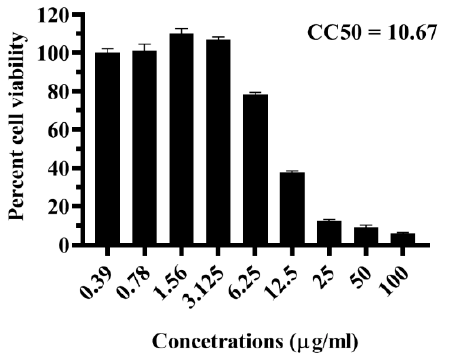
Figure 1. Effect of LFOB on cell viability as measured via MTT assay at two independent time points, the experiments were conducted in triplicate.